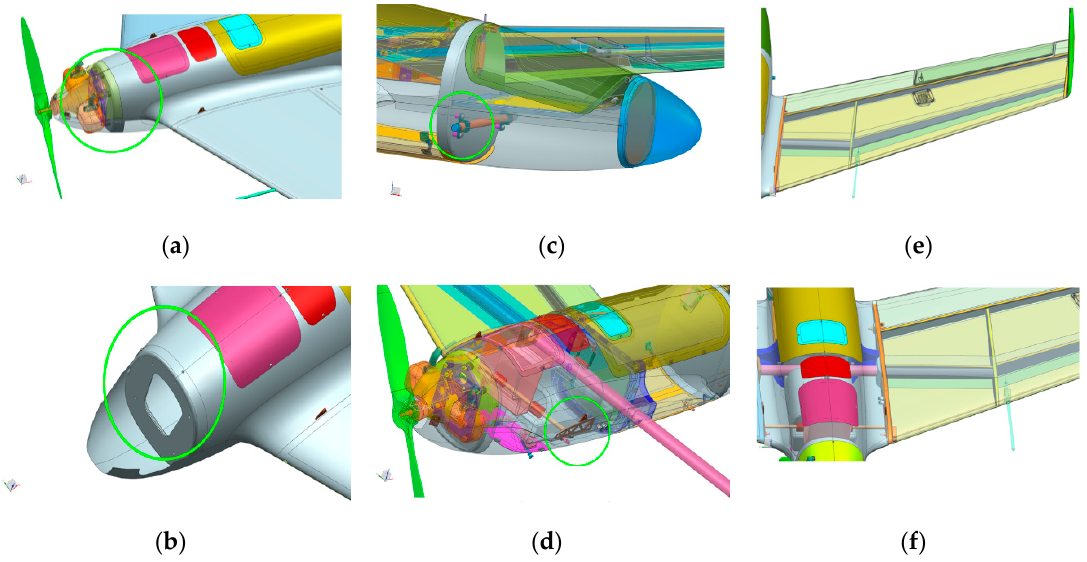
Figure 10. Critical areas of the Hornet UAV structure ( a ) propeller mounting area ( b ) propeller mounting